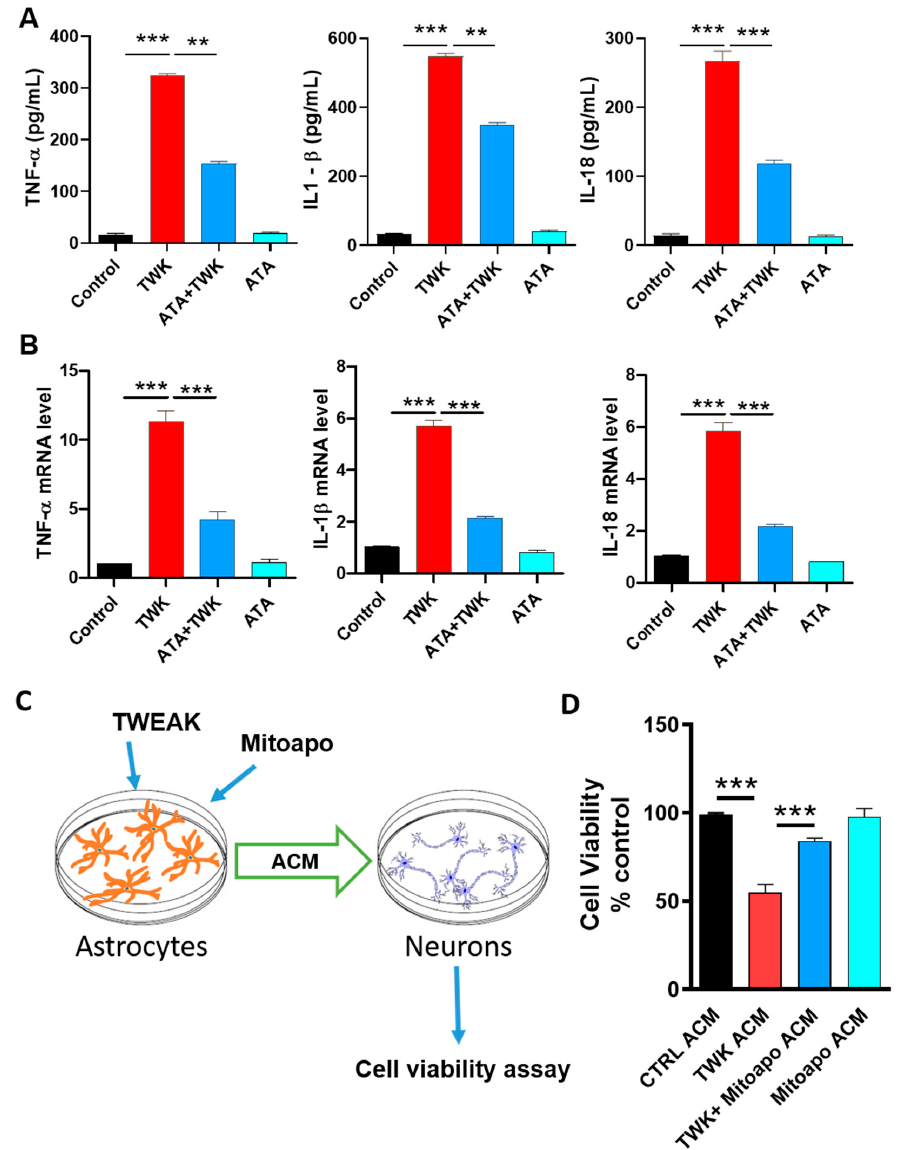
Figure 6. Aurintricarboxylic acid (ATA) attenuates the TWEAK-induced release of pro-inflammatory cytokines and mito-apocynin suppresses TWEAK astrocyte-conditioned media (ACM)-induced DA ergic neurotoxicity. Human astrocyte (U373) cells were pretreated with ATA (10 µ M) for 2 h, followed